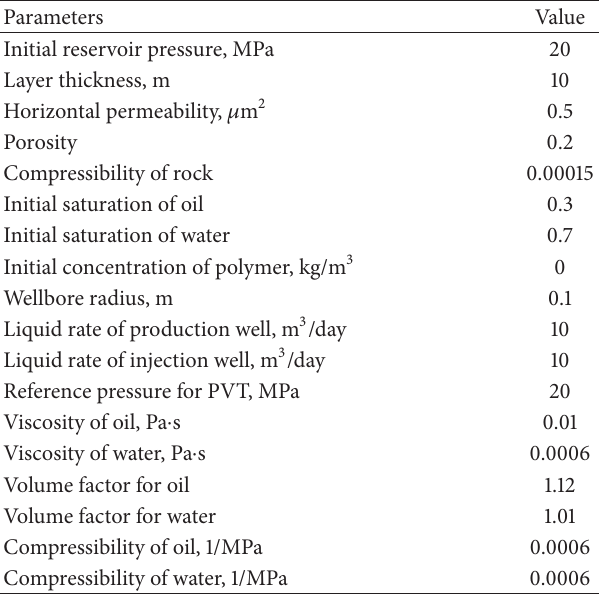
Table 1: Reservoir parameters.